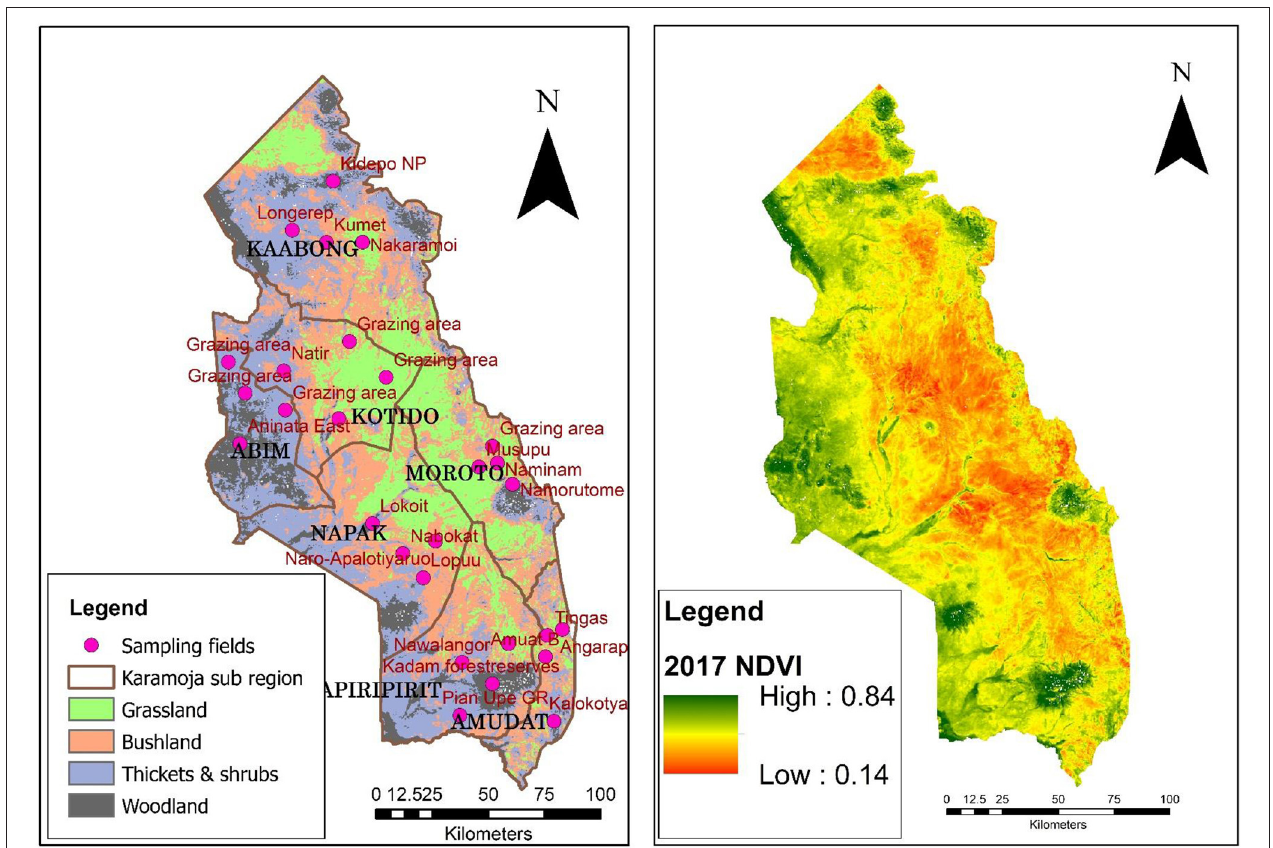
FIGURE 2 | Left-Locations of homogeneous sample fields and major land cover map derived from NDVI and right- NDVI values for the study region in